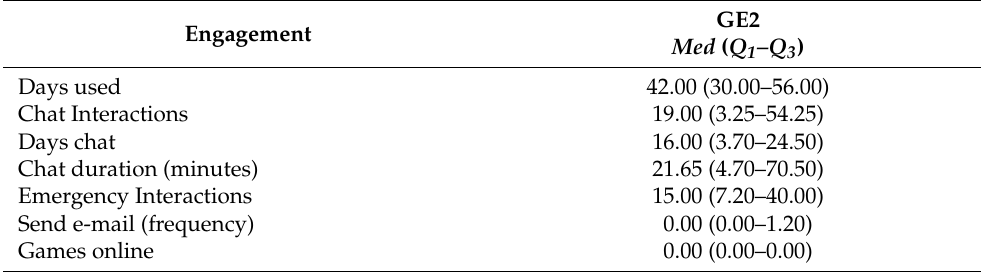
Table 4. Adherence GE2 non-smoking participants